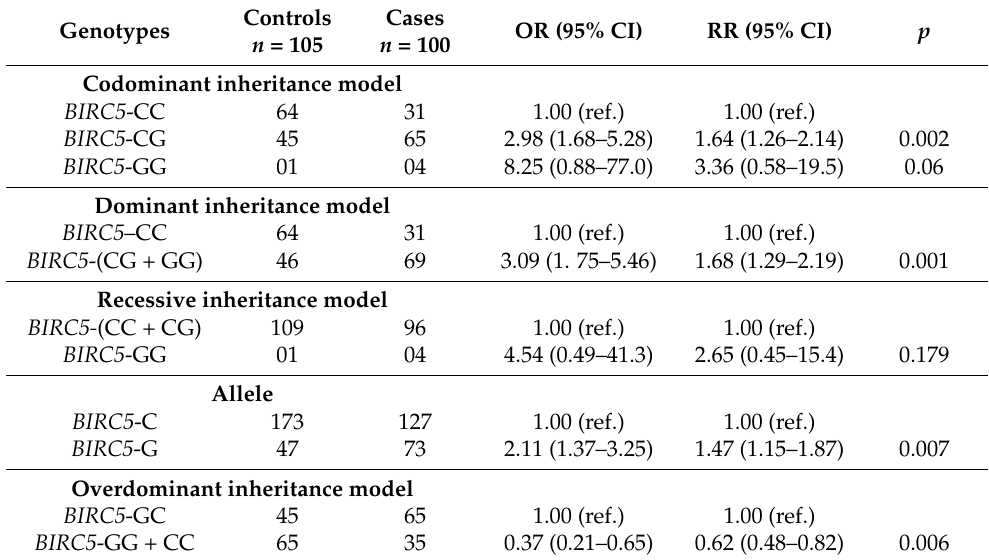
Table 6. Association of BIRC5-rs 17882312 C > G gene variation in cases and controls.